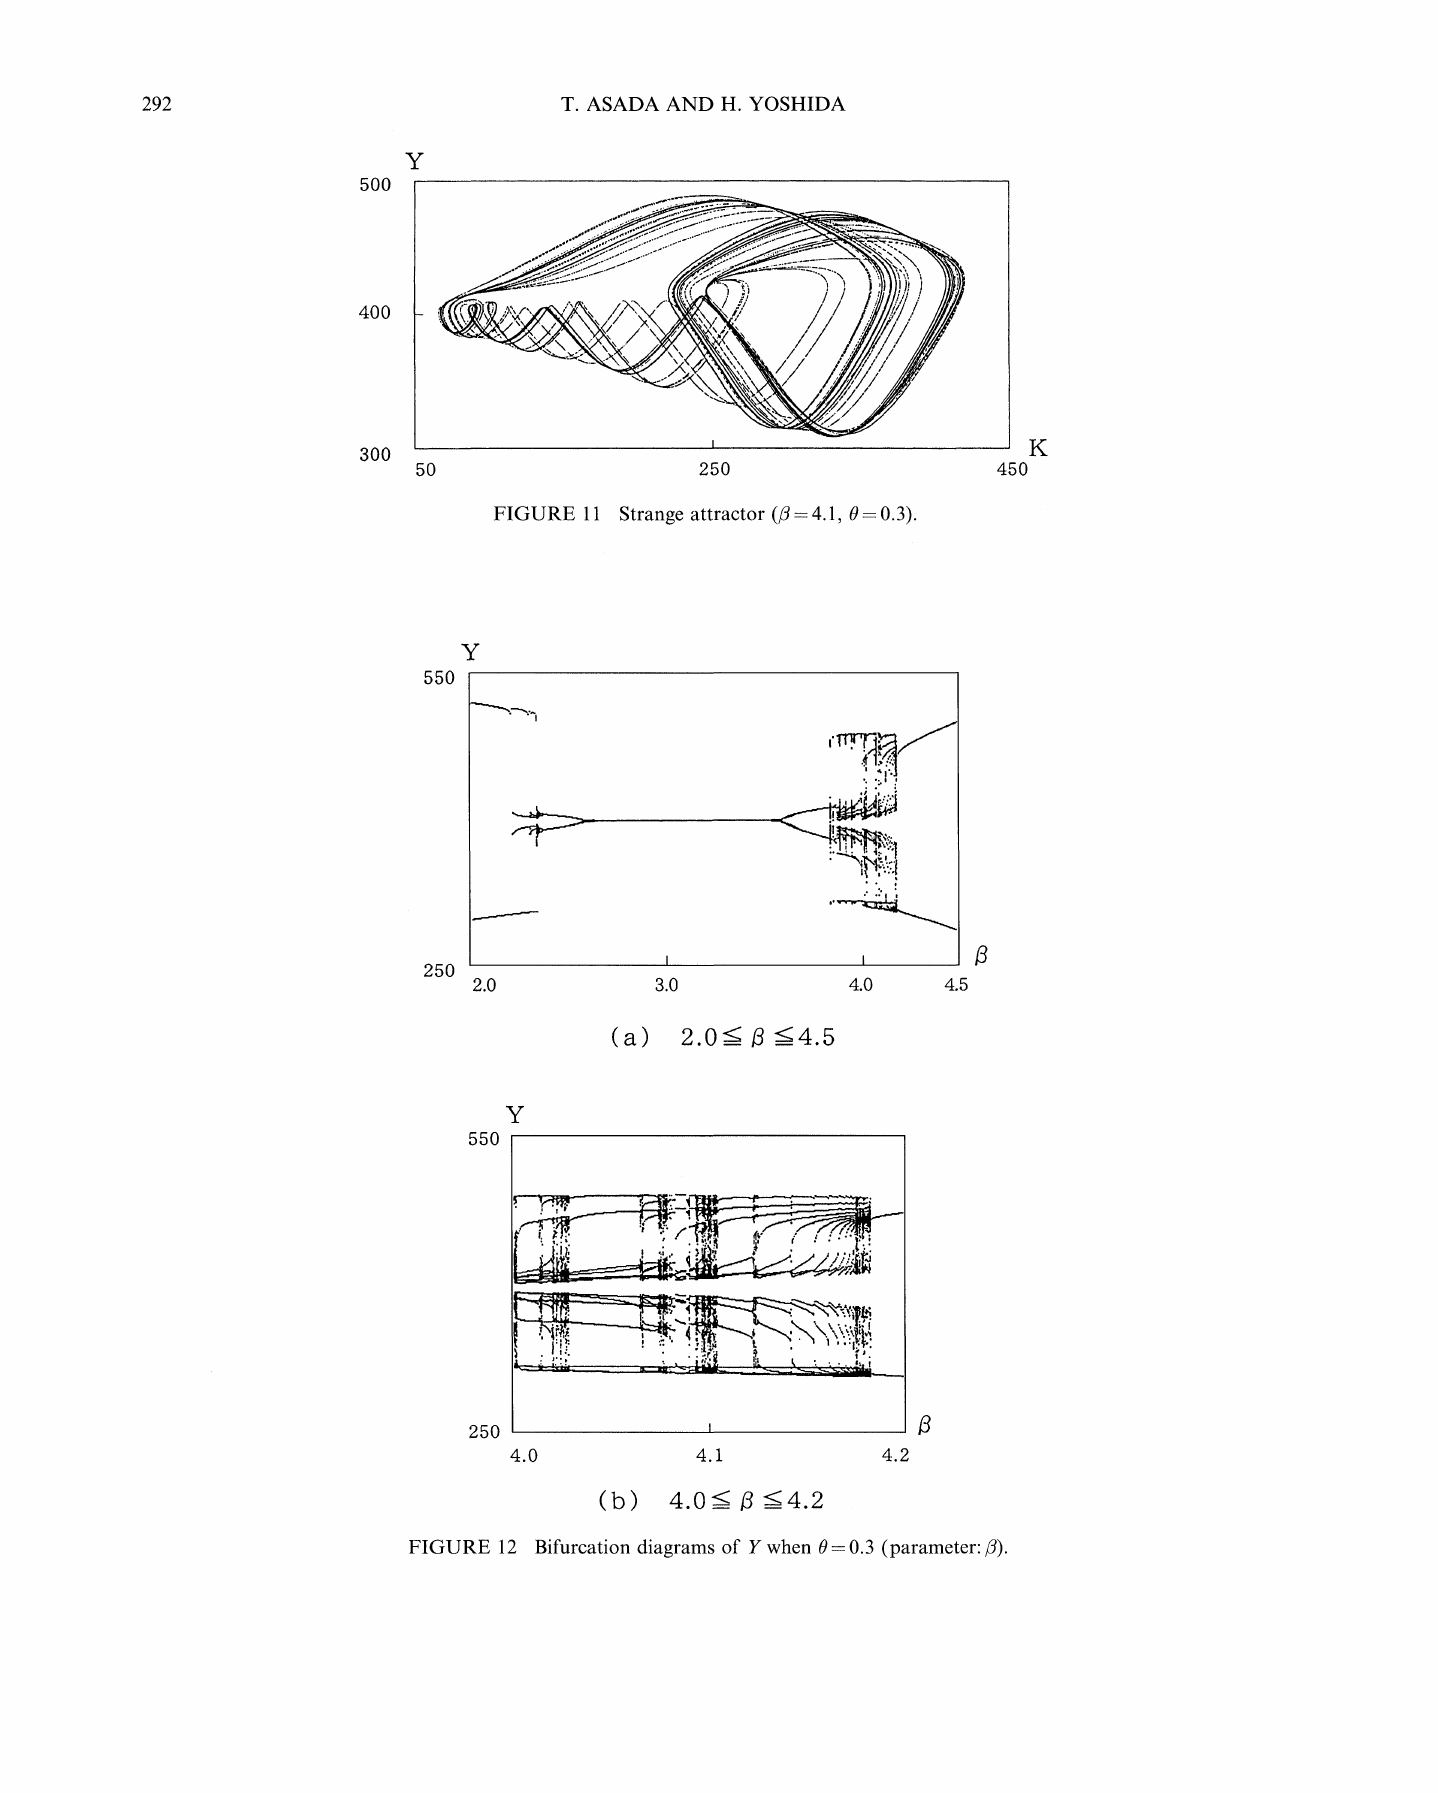
FIGURE 12 Bifurcation diagrams of Y when 0=0.3